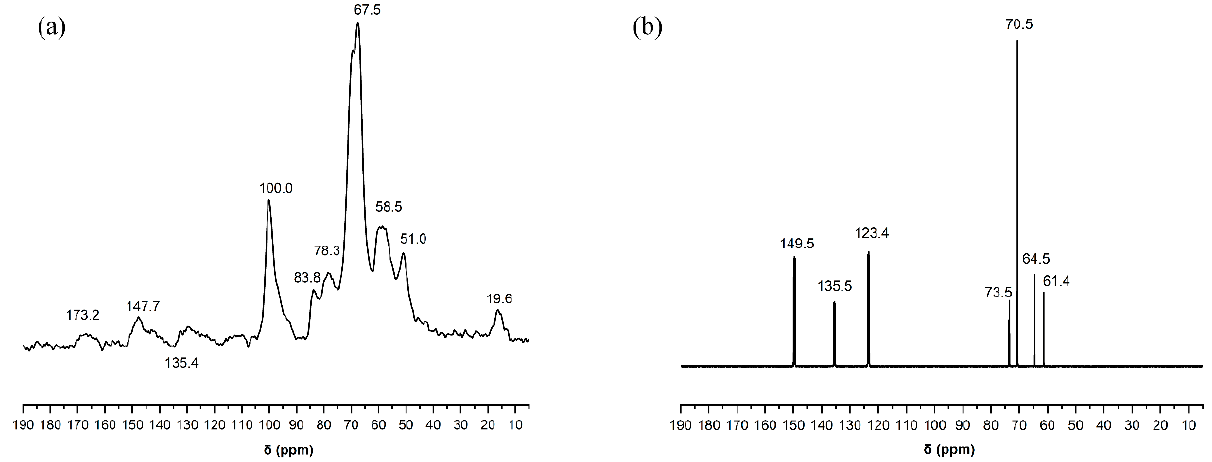
Figure 5. ( a ) 13 C-NMR spectra of poplar powder. ( b ) 13 C-NMR spectra of 110 min liquefaction products.